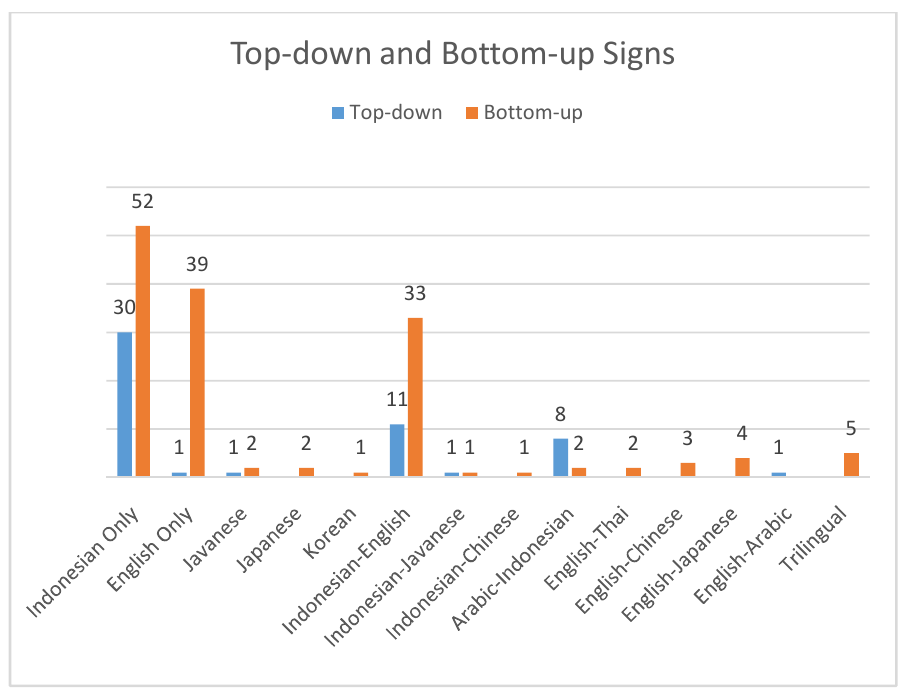
Figure 4. Public and Private Signs in